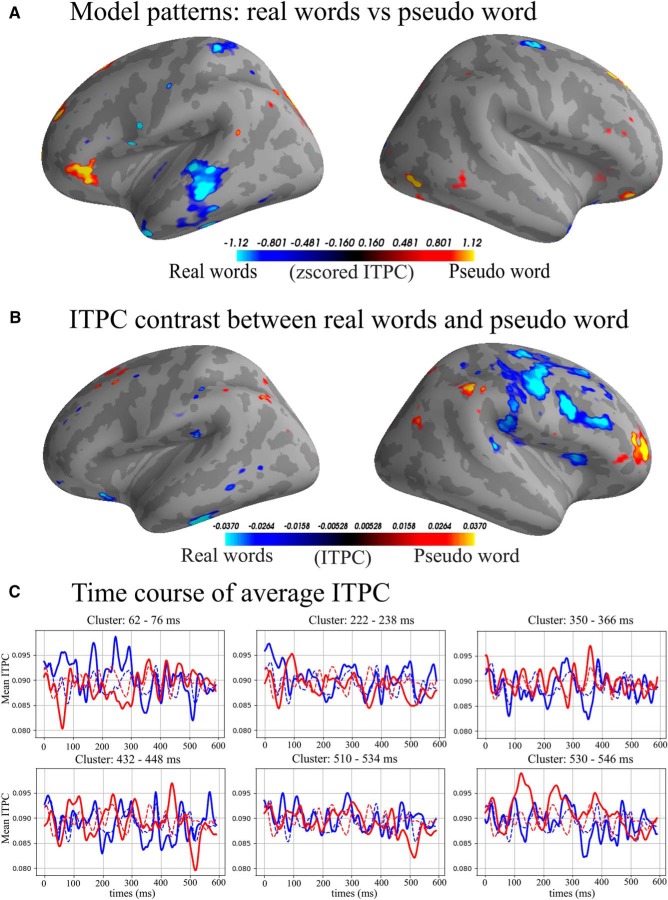
A, Model patterns: interpreting coefficients of a machine learning model is not trivial and a high coefficient value does not necessitate a high signal value in the MEG data (for details, see Haufe et al., 2014). “Model patterns” are a way to highlight the signal in a neurophysiological sensible way that is directly interpretable compared to the raw coefficients (Haufe et al., 2014). We show top and bottom 5% of the patterns in the γ-low band from 222 to 238 ms. Blue colors are areas of activation able to predict real words and yellow/red are areas used to predict pseudo word. B, Average top and bottom 5% of ITPC difference; blue colors indicate higher ITPC for real words and yellow/red colors indicate higher ITPC for pseudo word γ-low band from 222 to 238 ms. C, Average ITPC over time; solid lines are the average of the selected features, dashed lines are the average of all vertices in the source space. Time 0 is the divergence point, when stimuli could be recognized from the available acoustic information.